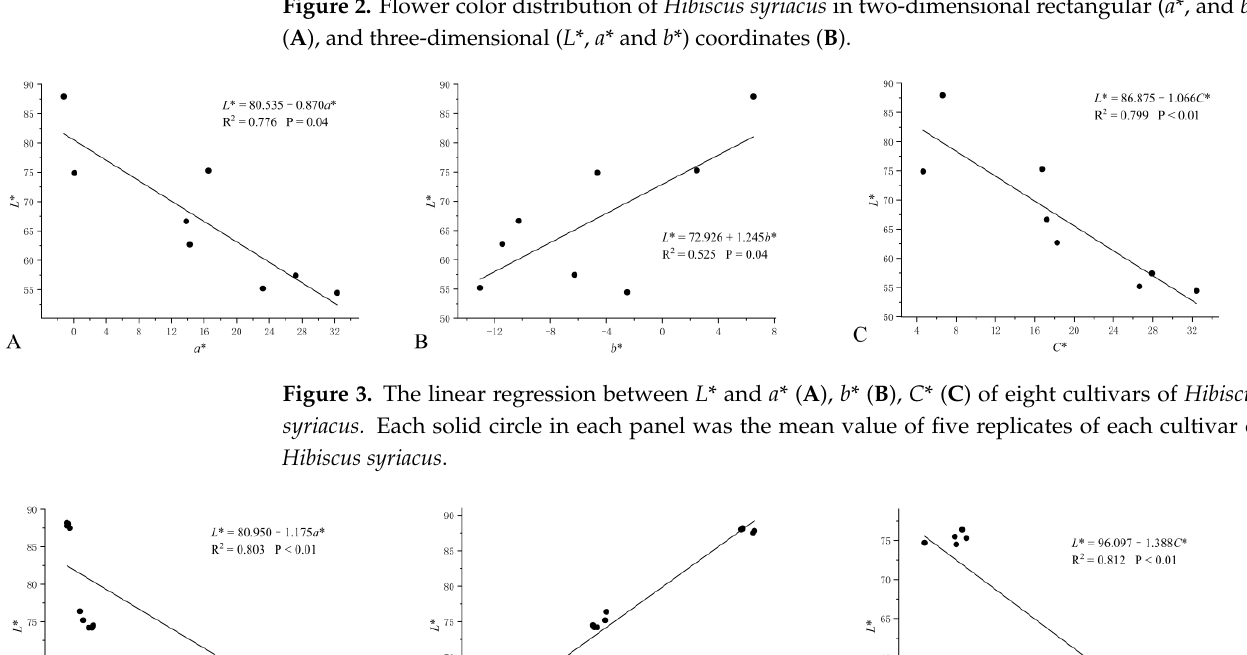
tection technology had good repeatability. Based on the local metabolite database, quali- tative and quantitative mass spectrometry analysis of metabolites in the samples was per- formed. In the picture (Figure 5C), each peak of a different color represents the detected metabolite. Information about metabolite serial numbers, peak integration values, and metabolite names is listed in Table 1. In total, 52 anthocyanins were identified, among which were cyanidin, delphinidin, malvidin, petunidin, peonidin, and pelargonidin, and ‘Pink Giant’ contained the greatest number of species of the anthocyanin component (47), and ‘Albus Single’ contained the lowest number, with only 20 (Figure 6A). As for the total anthocyanin content, it was found that ‘Albus Single’ contained the smallest amount at 3.13 μg g −1 , and ‘Pink Giant’ contained the highest amount at 2713.21 μg g −1 (Figure 6B). The highest content identified among the different types of anthocyanins was for cya- nidin, the lowest was for pelargonidin. We found that the color of the flowers changed from white to pink to blue to purple to red-purple as the total anthocyanin content in- creased.